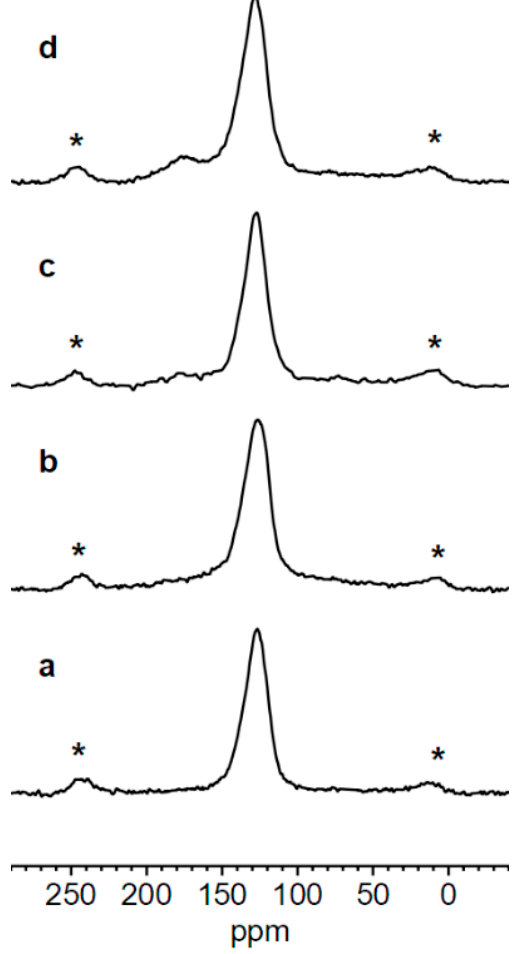
Figure 6. Comparison of 13 C CP MAS and SPE spectra of wB ( a , b , respectively) and of pAC_meso ( c , d , respectively). Sidebands are marked with asterisks.